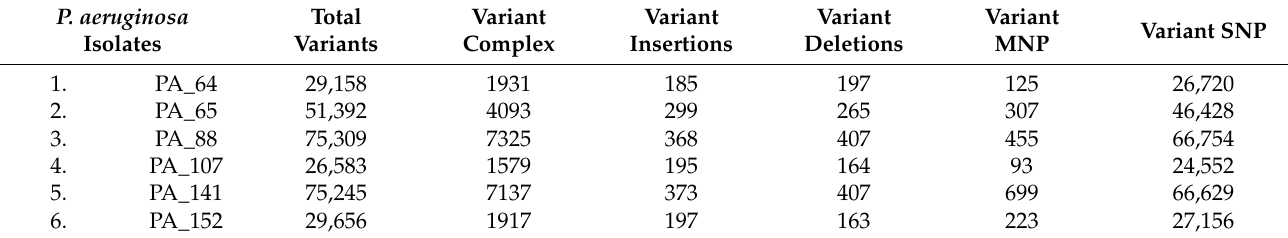
Table 4. Frequency of different types of variations found in the genes of P. aeruginosa